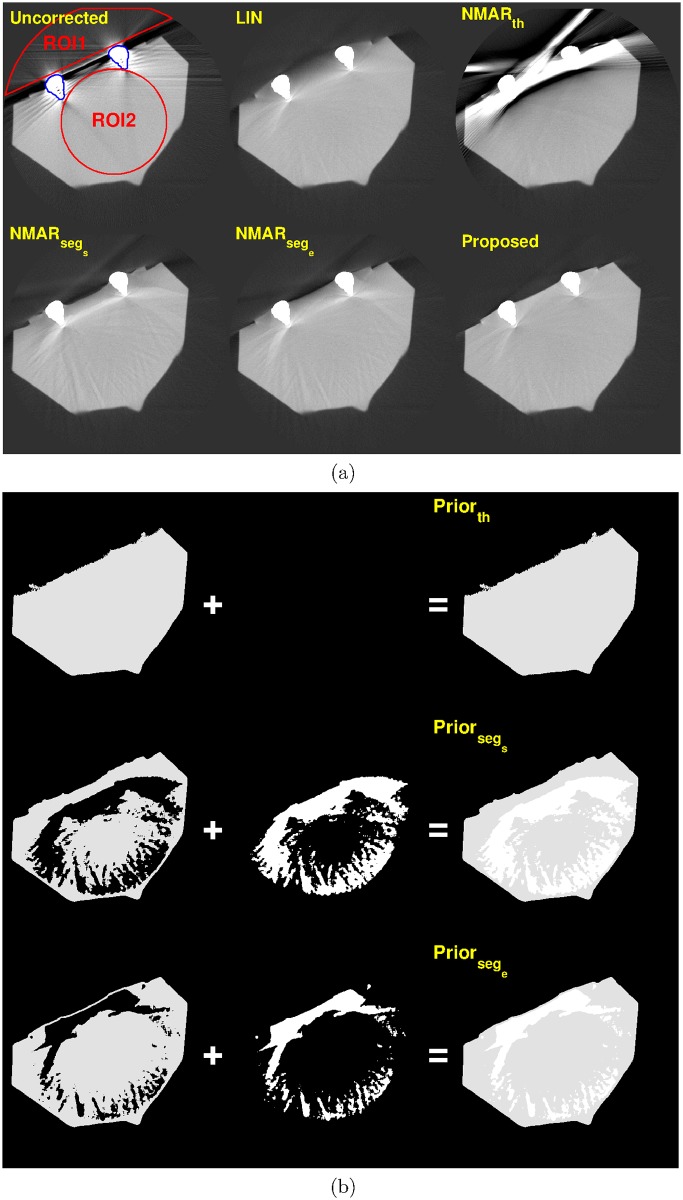
Results of tooth phantom with orthodontic bracket, on slice # 17 (C = -250 HU/W = 1250 HU).(a) Top row: reconstruction images by (left) Uncorrected, (middle) LIN, and (right) NMARth images. Bottom row: reconstruction images by (left) NMARsegs, (middle) NMARsege, and (right) the proposed results. ROI 1 and ROI 2 are indicated by red lines on the uncorrected image. (b) Prior images by (top) simple thresholding, (middle) RAC segmentation of LIN image, and (bottom) RAC segmentation of final iteration image.